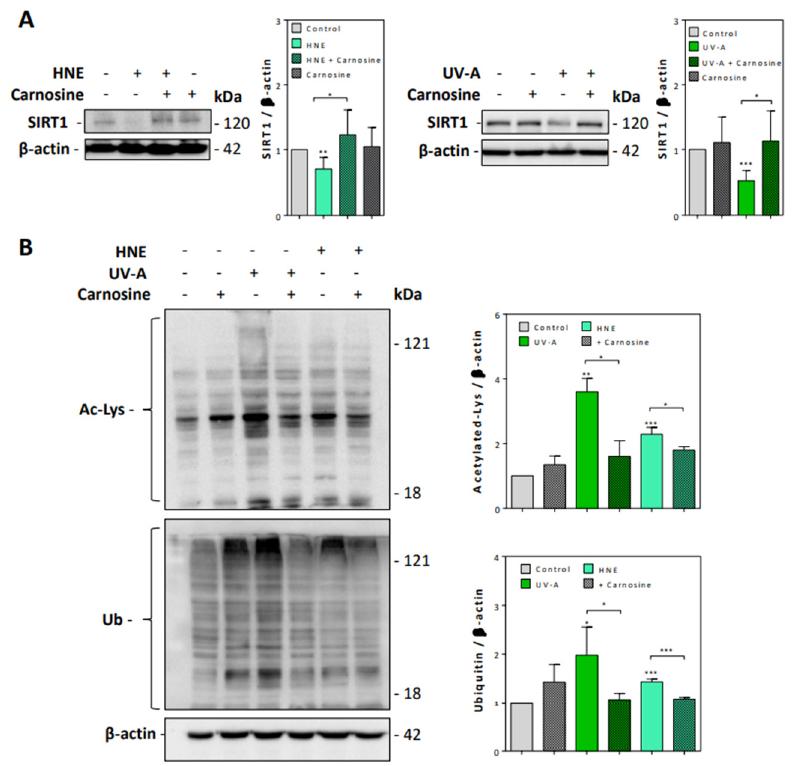
Figure 4. SIRT1 expression and accumulation of acetylated and ubiquitinated proteins in UV-A- and HNE-treated fibroblasts. ( A ), SIRT1 expression evaluated by western blot in fibroblasts exposed to UV-A or HNE, and protection by carnosine, using β -actin as control. Left panel, effect of HNE; right panel, effect of UV-A. On the right of each western blot picture, statistical quantification of SIRT1 in UV-A- or HNE-treated cells vs control untreated fibroblasts. ( B ), Western blot experiments showing the accumulation of acetylated (upper panel), and high molecular weight polyubiquitinated proteins (lower panel), in fibroblasts stimulated by HNE or UV-A, and protective effect of carnosine. Right panel, statistical quantification of acetylated and ubiquitinated vs control untreated fibroblasts. These results are a mean of four separate experiments and are expressed as means ± SEM.